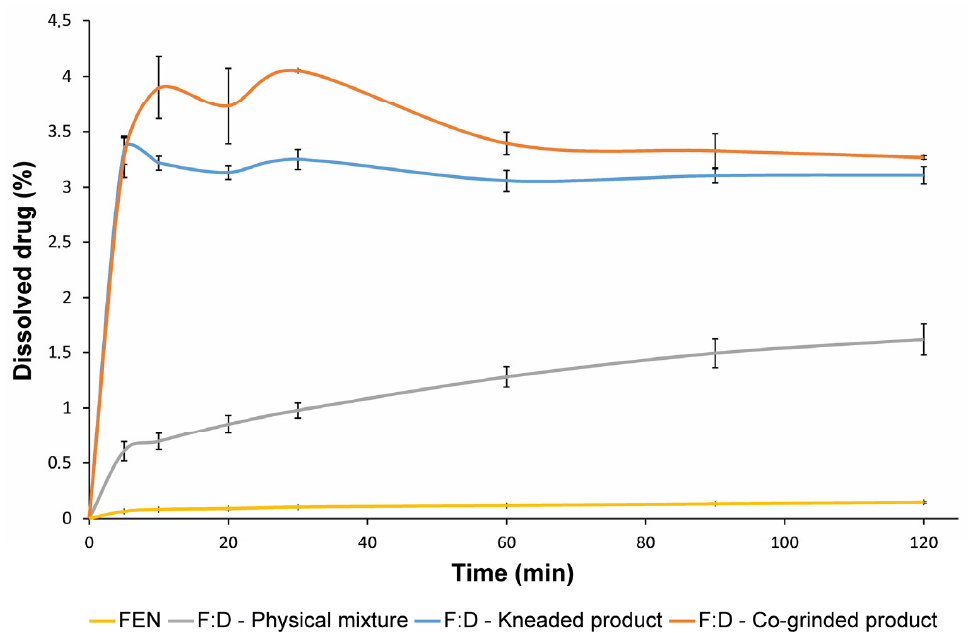
Figure 13. Dissolution curves of FEN, FEN:DIMEB (F:D) physical mixture, kneaded product, and co-ground product. All products show increased dissolution properties compared to pure FEN. Table 1. Calculated dissolution efficiency values at 60 and 120 min of FEN, and increased values of FEN:DIMEB (F:D) products.